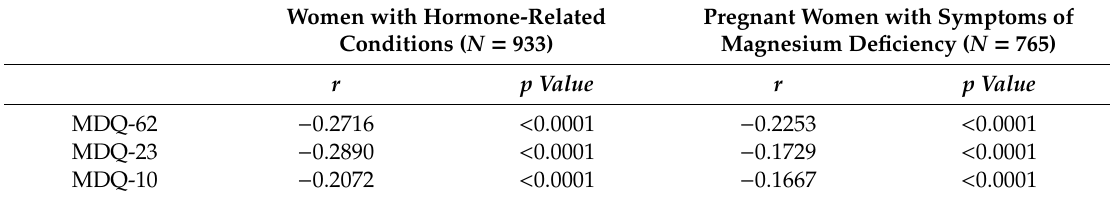
Table 3. Correlation between changes from Visit 1 to Visit 2 for total serum magnesium level and for initial (MDQ-62) and modified (MDQ-23 and MDQ-10) questionnaire scores. Women with Hormone-Related Pregnant Women with Symptoms of Conditions ( N = 933) Magnesium Deficiency ( N = 765) r p Value r p Value MDQ-62 − 0.2716 < 0.0001 − 0.2253 < 0.0001 MDQ-23 − 0.2890 < 0.0001 − 0.1729 < 0.0001 MDQ-10 − 0.2072 < 0.0001 − 0.1667 <